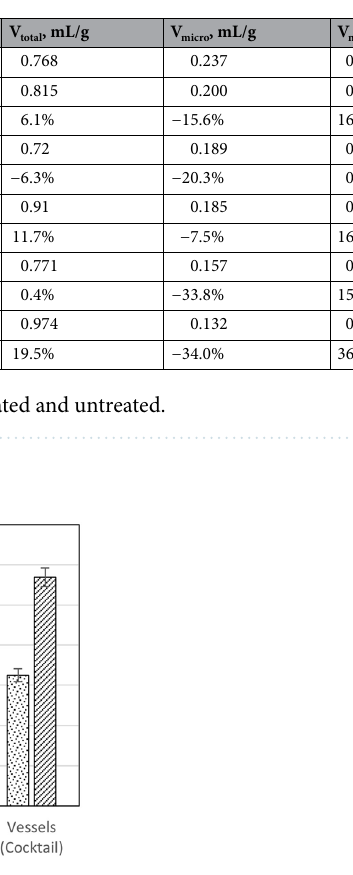
Figure 1. Freezing bound water (FBW) and non-freezing bound water (NFW).